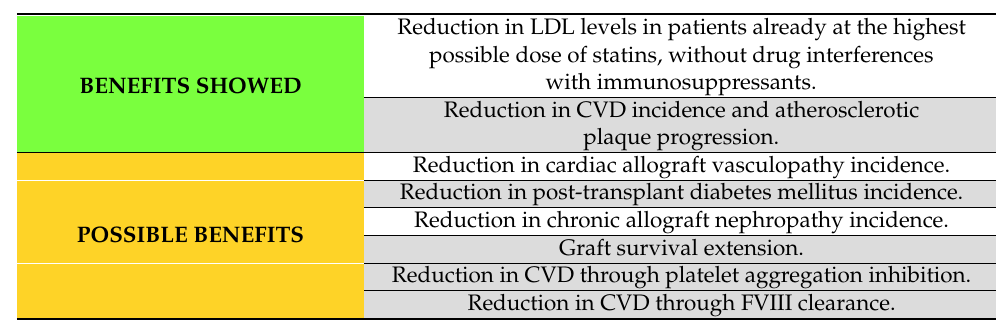
Table 1. Shown and possible PCSK9 inhibitor use benefits in transplant patients, CVD: cardiovascular disease; FVIII: coagulation factor VIII; LDL: low-density